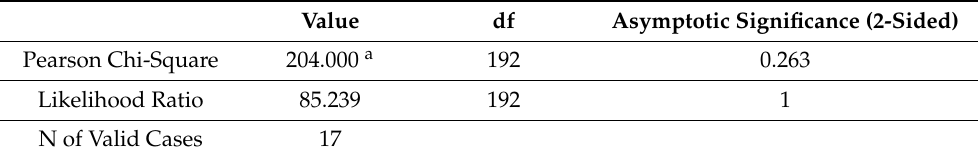
Table 4. Chi 2 test for interrater reliability of the selected